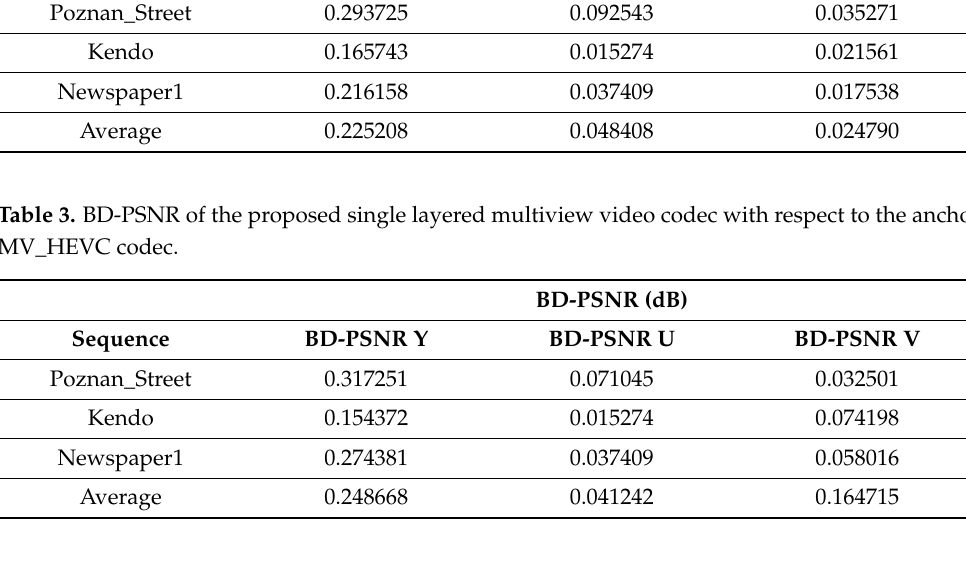
Table 4. BD-Rate of the proposed single-layered stereo video codec with respect to the anchor MV-HEVC